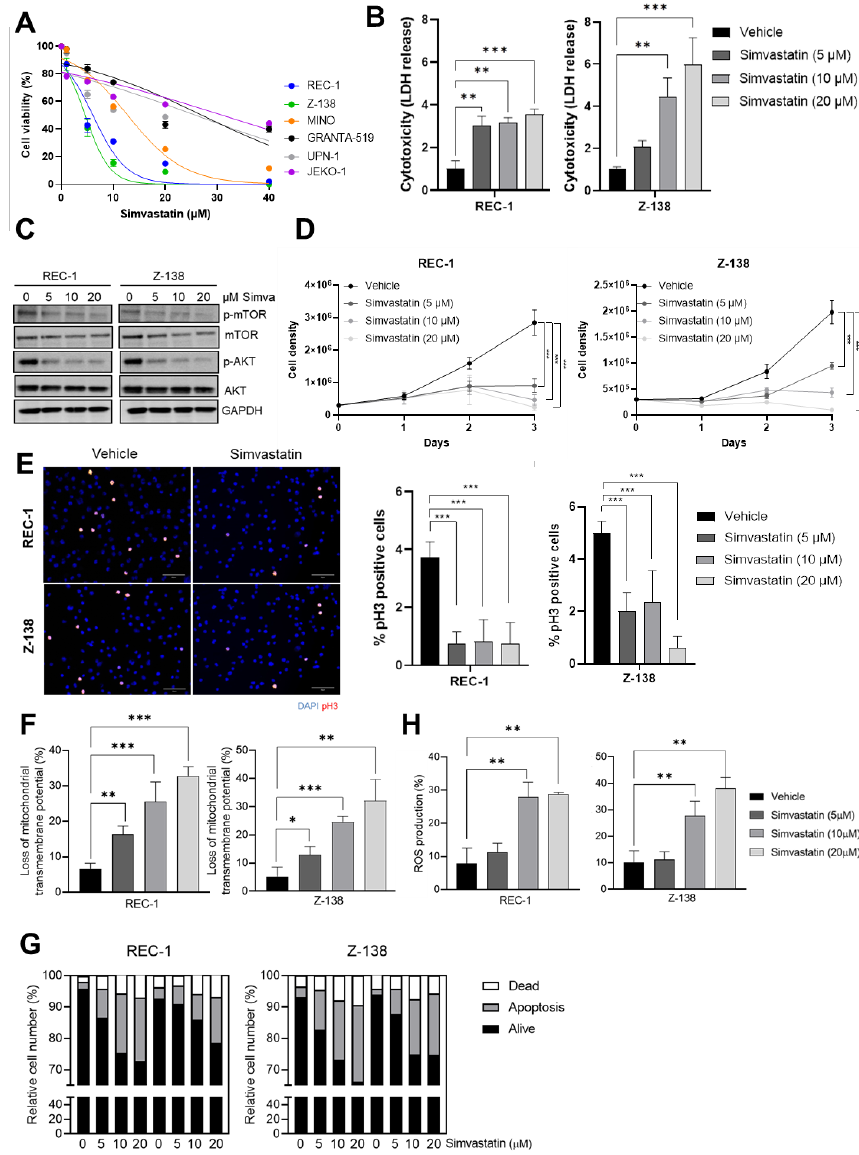
Figure 1. MCL cytotoxicity, proliferation impairment and cell death induced by simvastatin. ( A ) Cell viability of MCL cell lines in the presence or absence of different doses of simvastatin; ( B ) cytotoxicity rates assessed by LDH release of MCL cell lines in presence or absence of 5 µ M, 10 µ M and 20 µ M simvastatin; ( C ) Western blot evaluation of phospho-AKT and phospho-mTOR levels after the treatment with 5 µ M, 10 µ M and 20 µ M simvastatin, or vehicle. Full western blot images can be seen in Figure S4. ( D ) Proliferation rate assessed by MCL cell counting after the treatment with increasing doses of simvastatin; ( E ) proliferation rate assessed by phospho-Histone 3 (red) immunofluorescence of MCL cell lines in the presence or absence of 5 µ M, 10 µ M or 20 µ M simvastatin. Nuclei were counterstained with DAPI (blue); ( F ) mitochondrial transmembrane potential ( ∆Ψ m) after cell treatment with 5 µ M, 10 µ M or 20 µ M simvastatin or vehicle; ( G ) apoptosis rate measured by AnnexinV-FITC/PI staining after cell treatment with 5 µ M, 10 µ M or 20 µ M simvastatin or vehicle, previously treated or not with 10 µ M of the pan-caspase inhibitor, Q-VD-OPh hydrate; ( H ) ROS generation measured by DHE (dihydroethidium) staining in MCL cells lines treated with 5 µ M, 10 µ M or 20 µ M simvastatin, or vehicle. Values are expressed as mean ± SEM. * p < 0.05, ** p < 0.01, *** p < 0.001, when compared to control